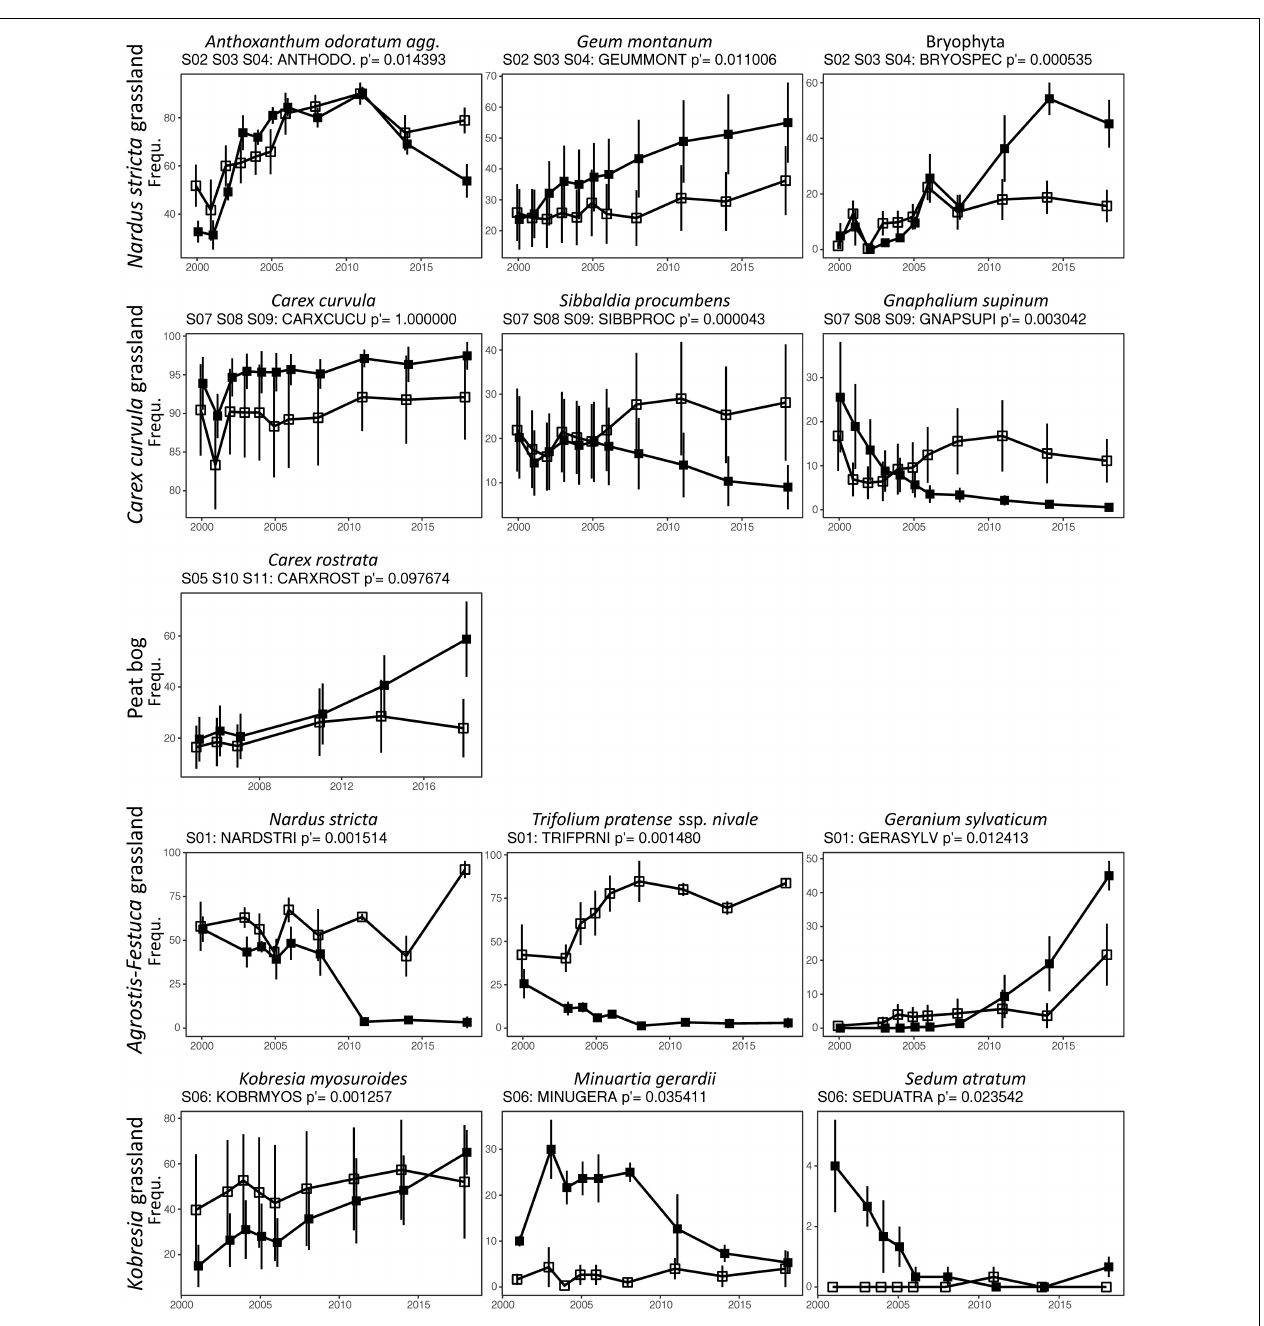
FIGURE 4 | Grazing effects on species frequency (tested by mixed-effect models, Bonferroni-corrected p < 0.05 for the exclosure × year interaction) for the different communities. Means ± S.E. for exclosure plots (filled squares) and grazed control plots (open